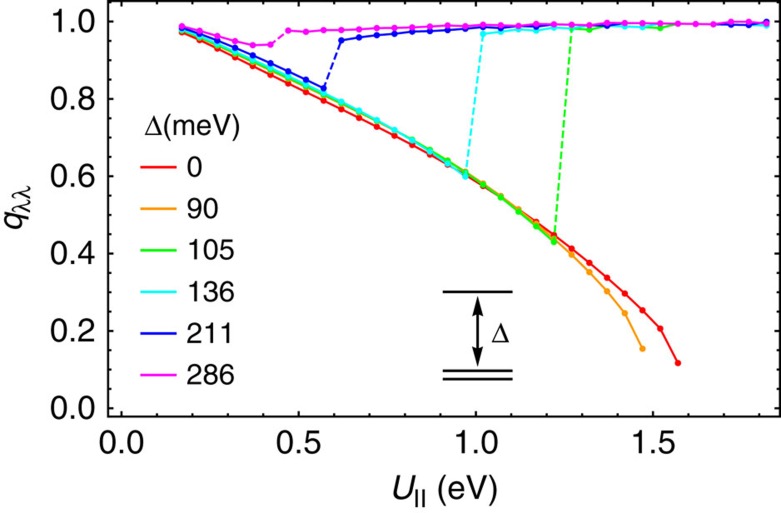
Transition from correlated metal to band insulator induced by orbital splitting.Evolution of the the Gutzwiller reduction factors qλλ for A4C60 within the cubic model used in Fig. 1 in function of U|| for different orbital gaps Δ, which are sums of JT and CF splittings (the former is considered arbitrary now). The monotonously decreasing line corresponds to a correlated metal, which for Δ<Δc (Δc≈100) evolves into a MH insulator. The jumps to qλλ≈1 for values Δ>Δc correspond to onsets of band insulator.